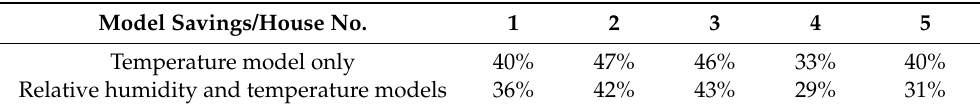
Figure 6. Actual outdoor relative humidity versus selected residences’ relative humidity for the whole dataset. Table 6. Savings from the implementation of thermal comfort control for the residences considered in study.